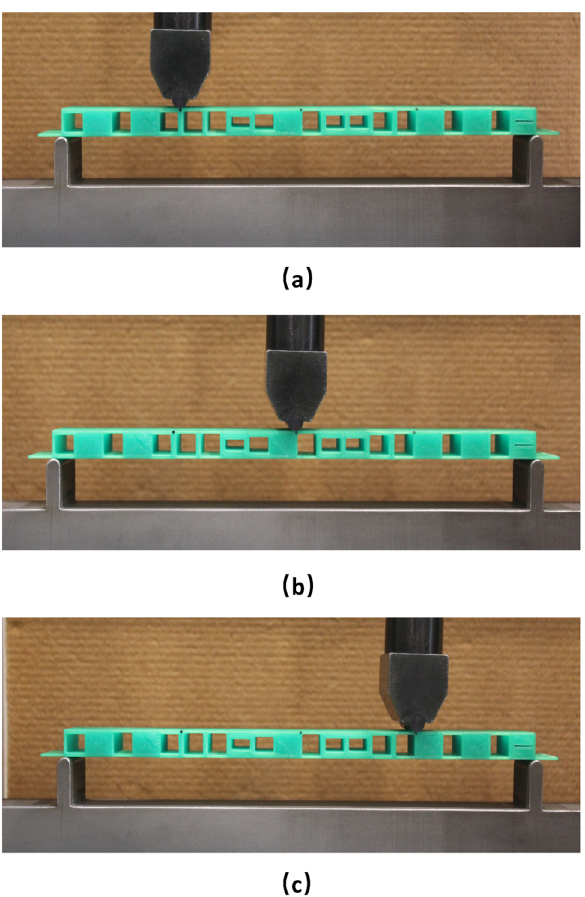
Figure 20. Experimental three-point bending tests; ( a – c ) indicate loading points 1 to 3 (Image is based on the photograph taken by the